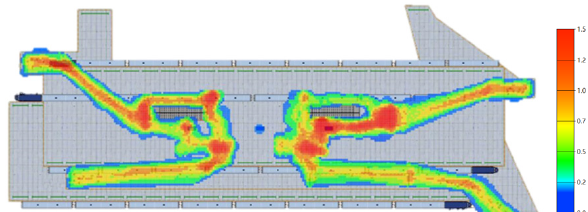
Figure 11. Pedestrian distribution density at 180 s.